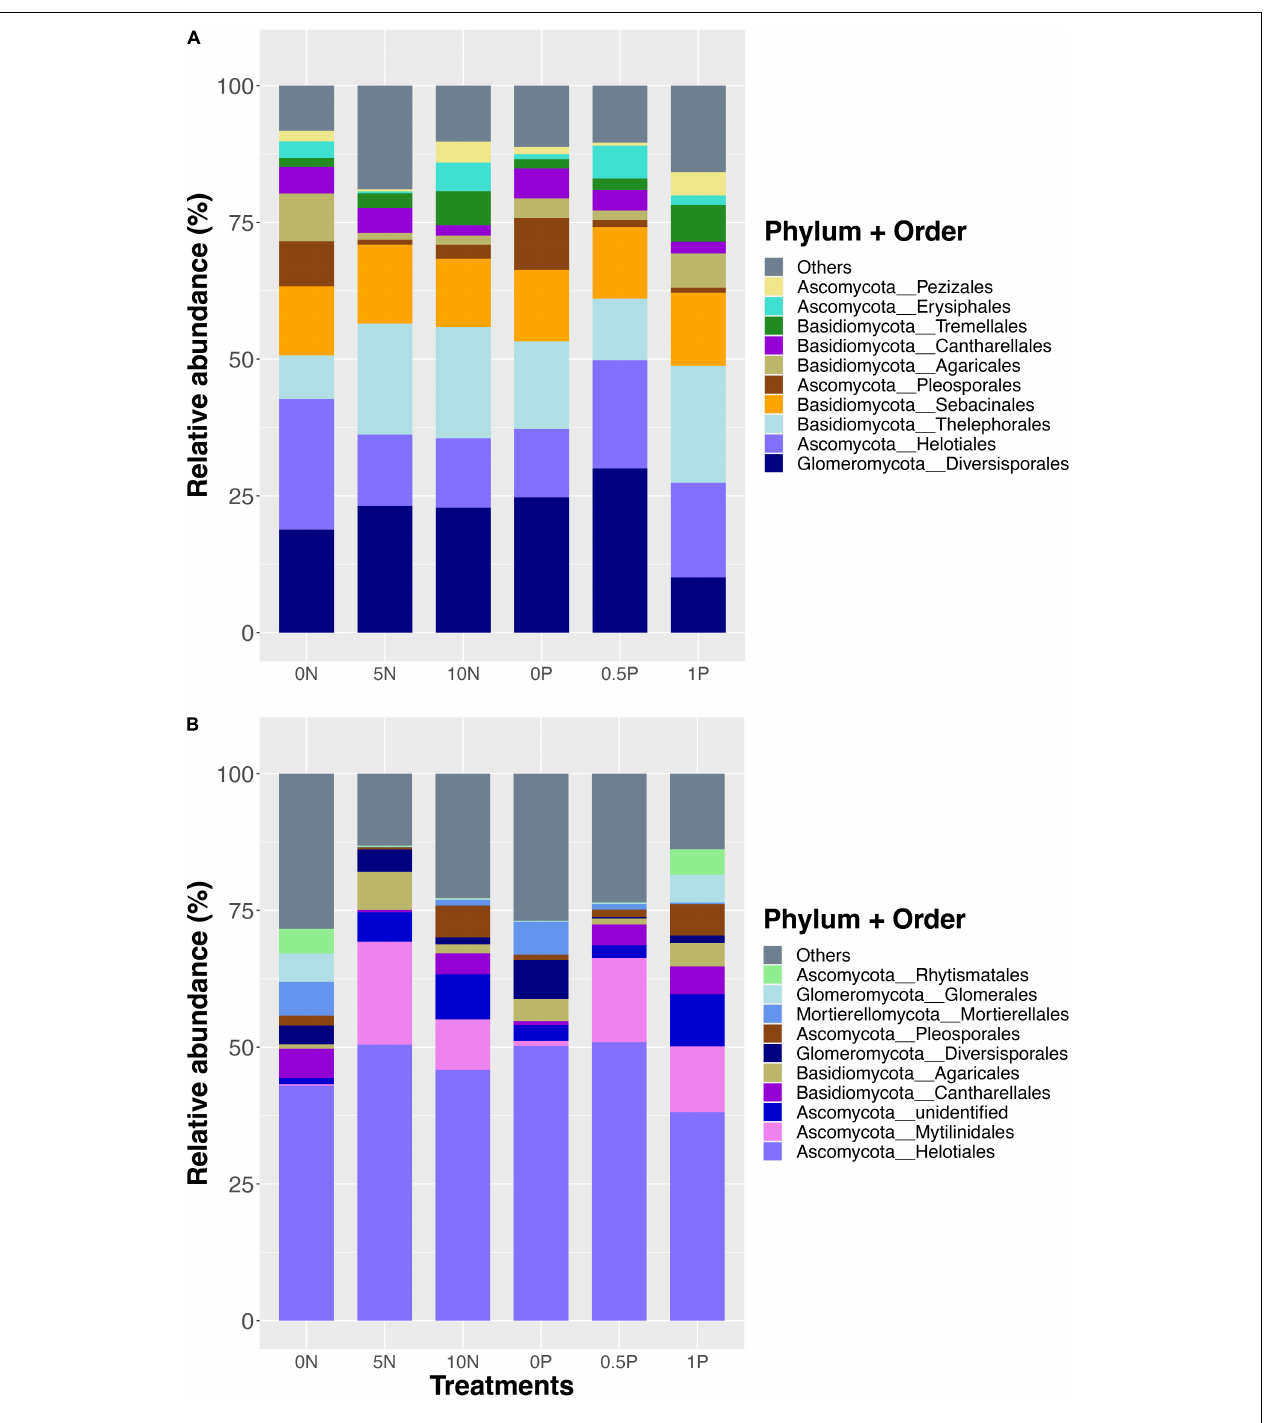
FIGURE 1 | Relative abundance of dominant fungal orders after short- (A) and long-term (B) fertilization. Stacked bars are ordered by decreasing the number of total sequences per order (bottom to top) for each fertilization experiment separately. Treatment abbreviations as described in “Materials and Methods” section.